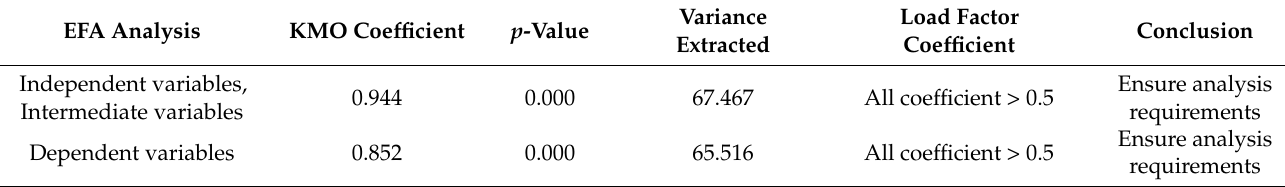
Table 3. Results of analysis EFA